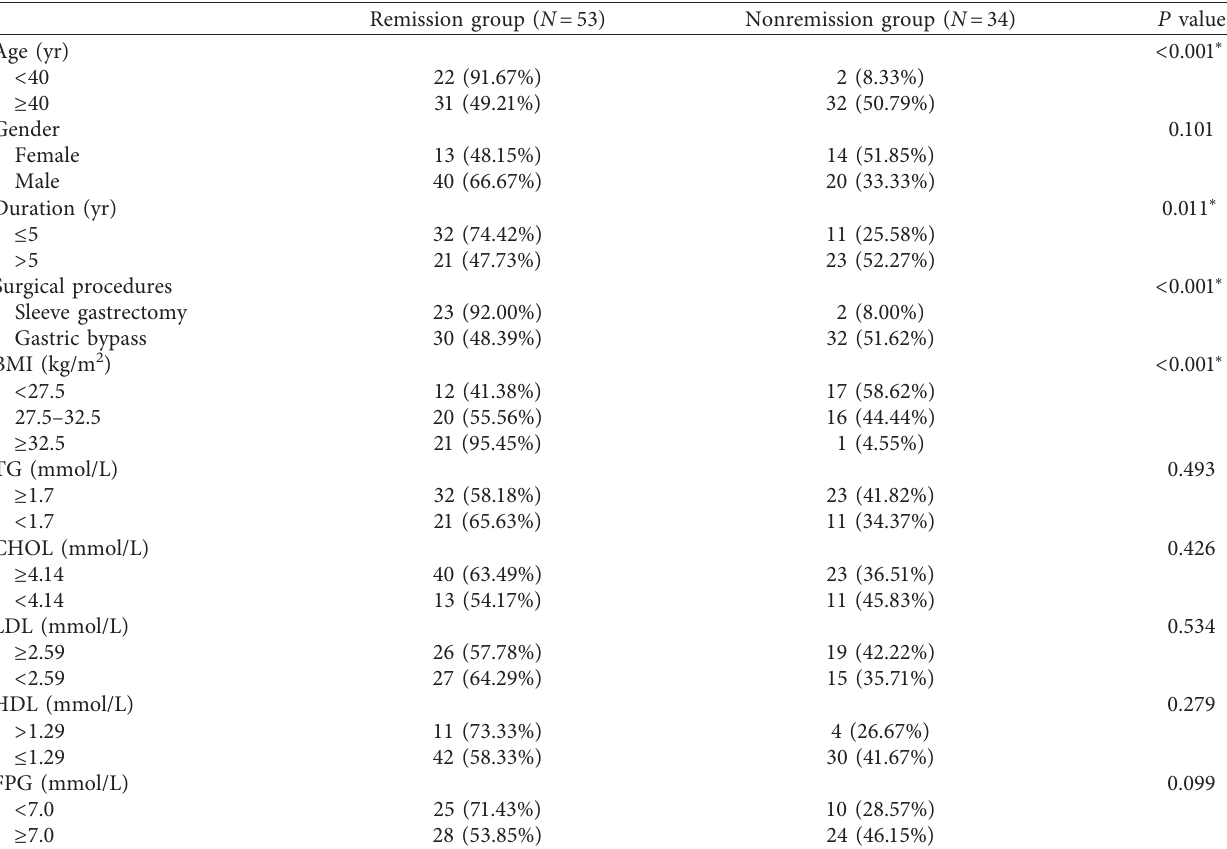
Table 2: Univariate analysis of remission predictors 1-2 years after